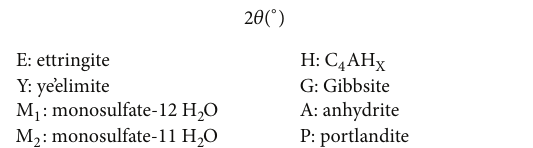
Figure 4: DTA of hydrated ye’elimite clinker exposed to laboratory conditions (E = ettringite).